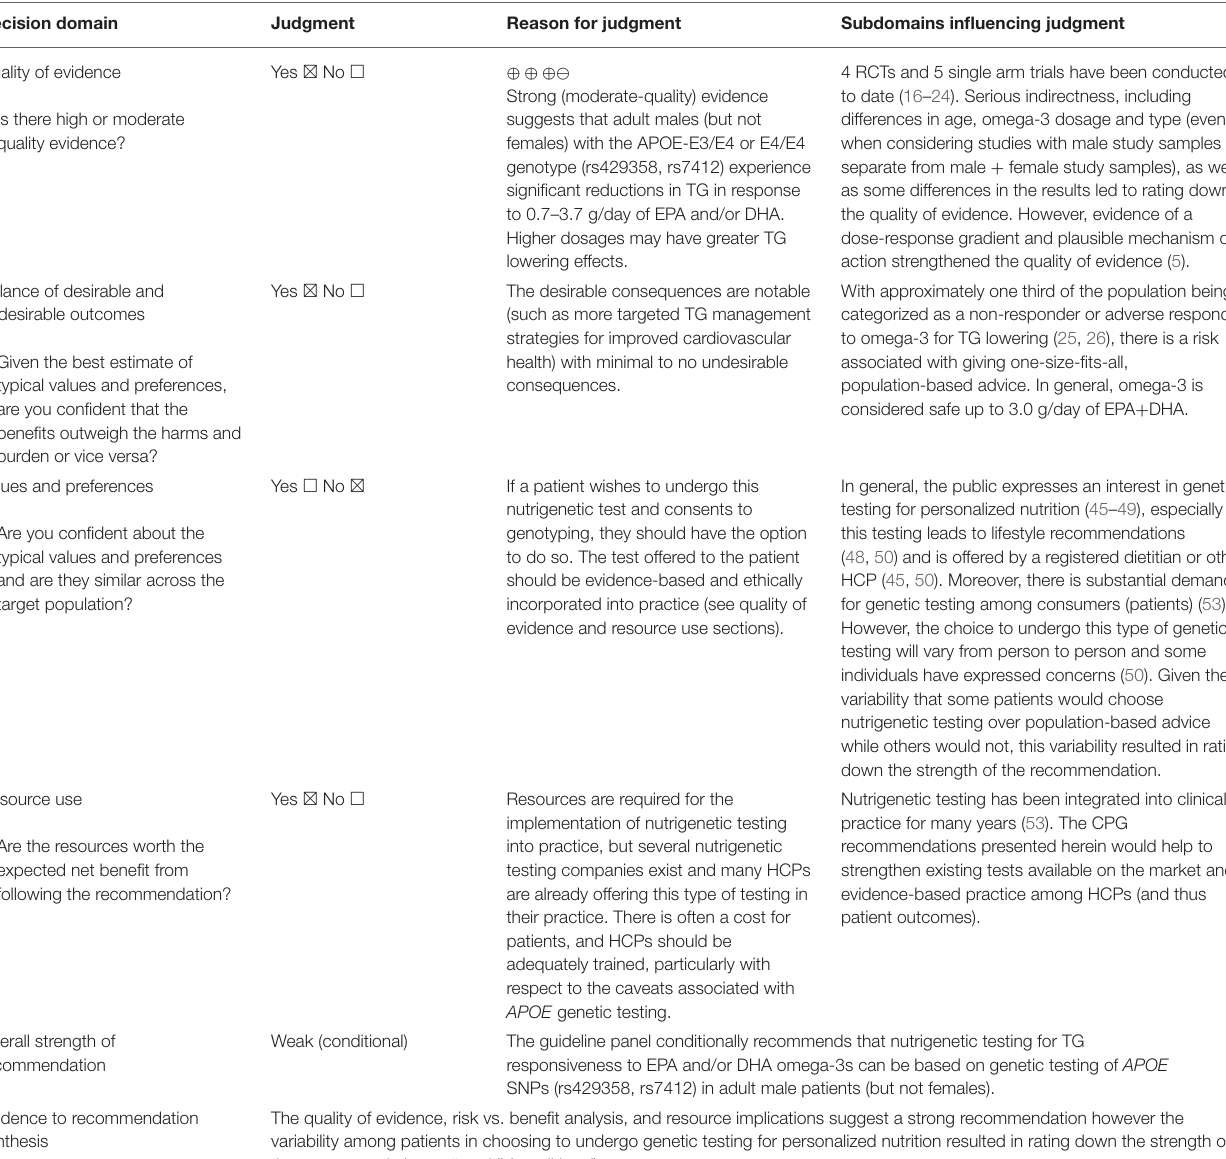
TABLE 1a | APOE (rs429358 and rs7412) genetic testing to evaluate the TG responsiveness to dietary/supplemental EPA + DHA in